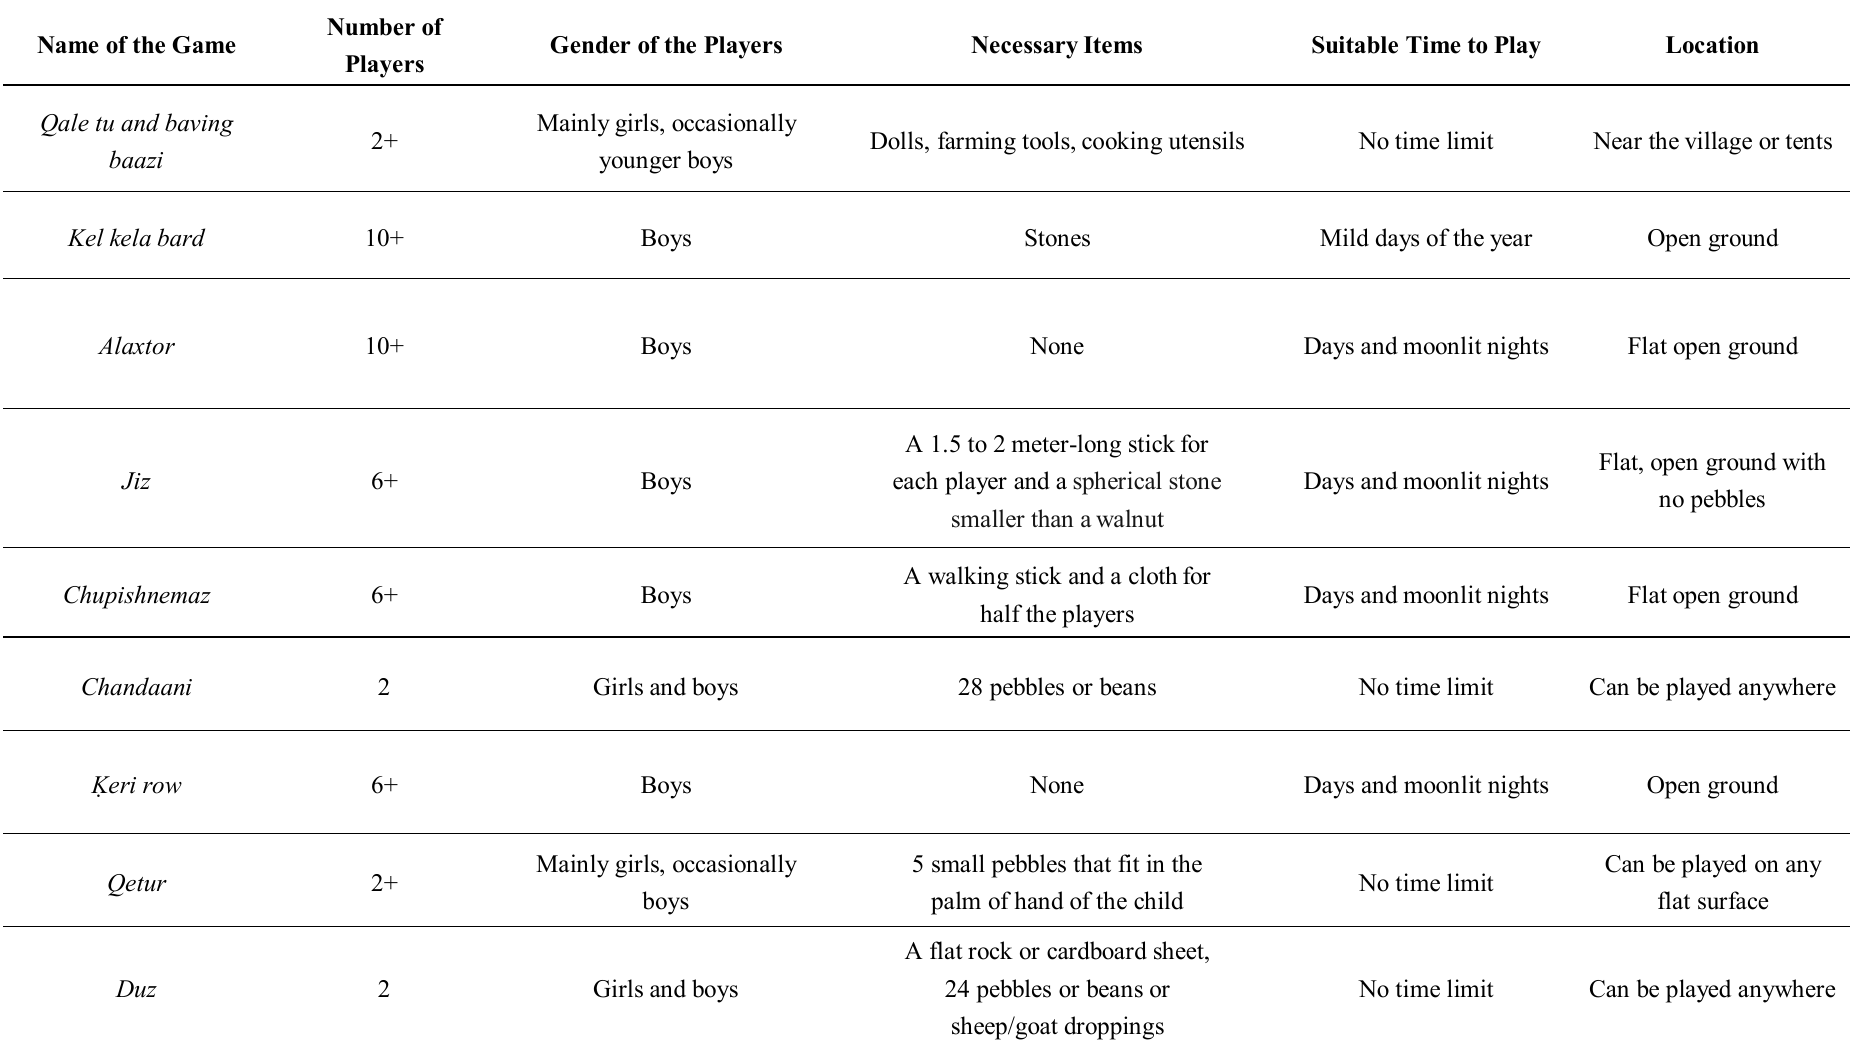
Table 1. Features of some native